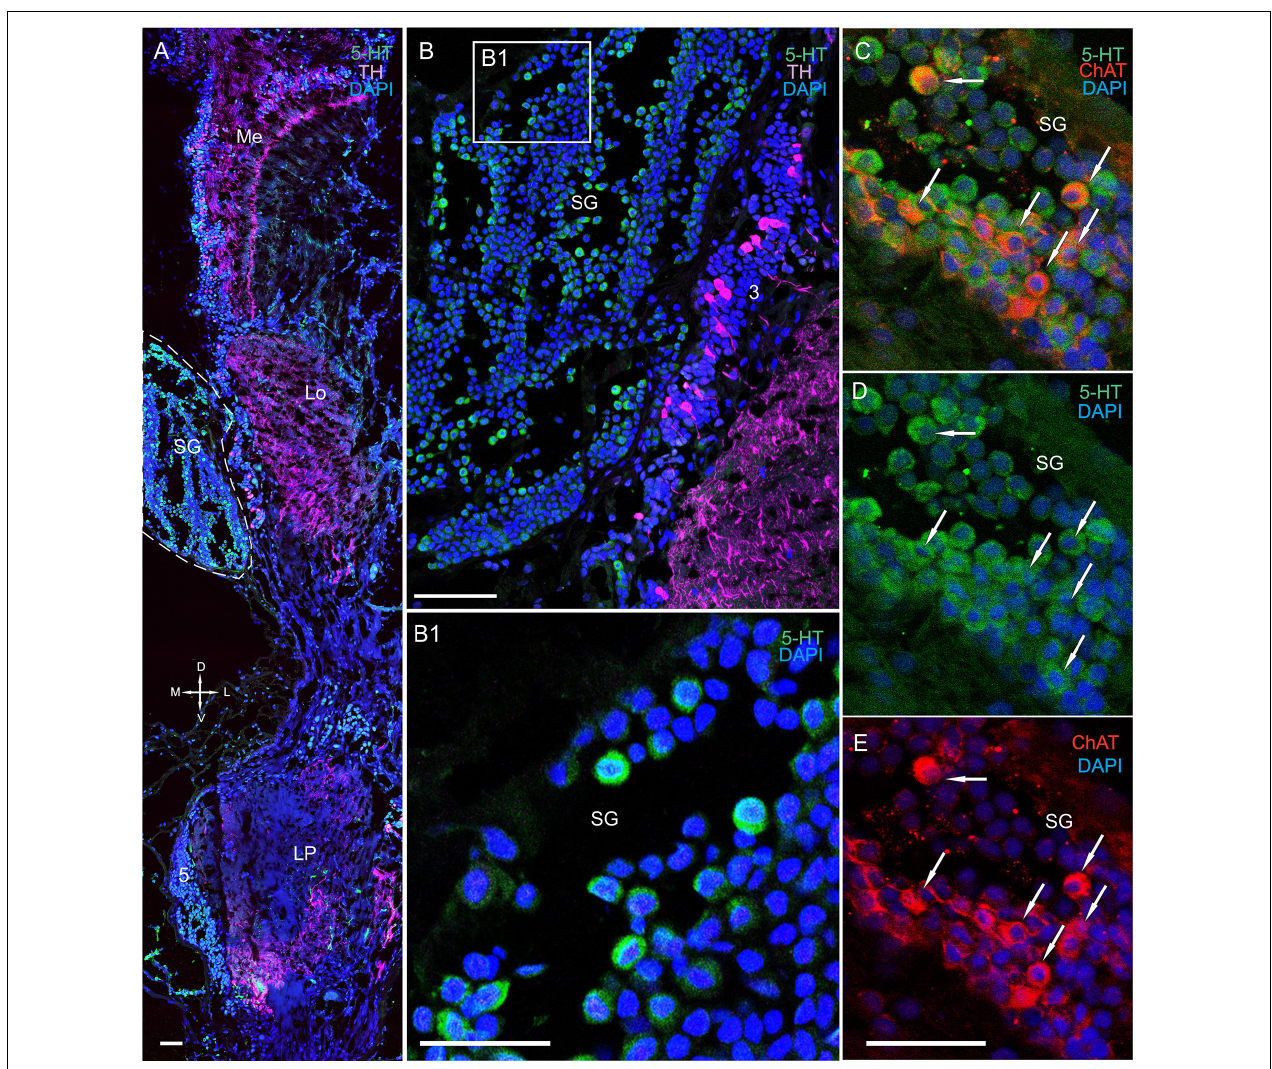
FIGURE 9 | Immunolocalization of 5-HT, TH, and ChAT in the lobula and SG. (A) Tissue section through an eyestalk of Paralithodes camtschaticus displaying the location of the SG near the Lo. (B) Somata of TH-positive neurons located in cluster 3 near the SG. (B1) Inset (B1) shows 5-HT-positive immunostaining at higher magnification in the endogenous cells of the SG. (C–E) Double immunolabeling of 5-HT and ChAT in cells of the SG and showing co-localization of 5-HT with ChAT in few of the cells (arrows). Green, 5-HT; red, ChAT; magenta, TH; blue, DAPI. Dashed line indicates cells corresponding to the SG. Scale bars = (A,B) 100 µ m and (B1–E) 50 µ